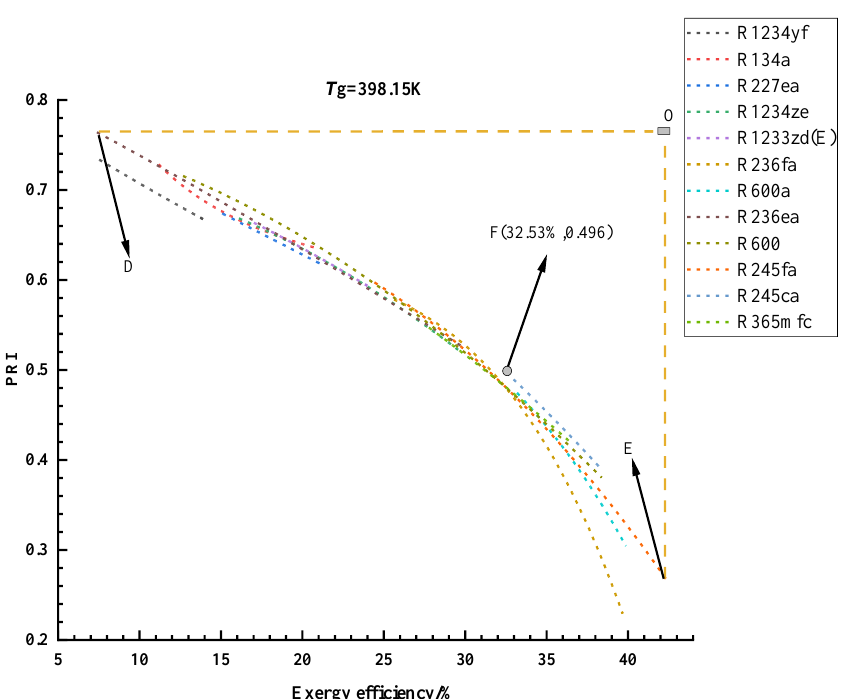
Figure 10. Optimized results of CS under the heat source temperature of 398.15 K.